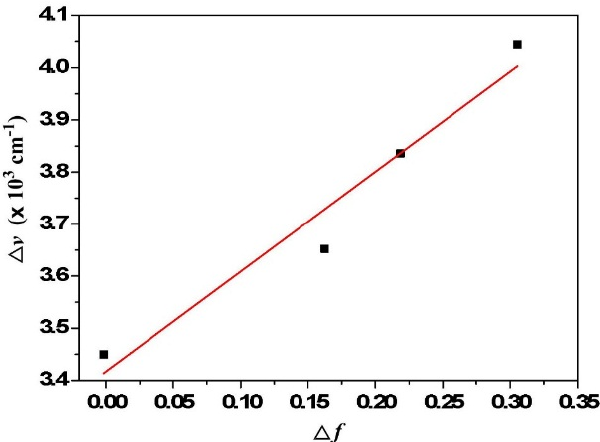
Figure 8. Lippert-Mataga plot for 4 . The solvents from left to right are: (1) cyclohexane; (2) diethyl ether; (3) dichloromethane; (4)